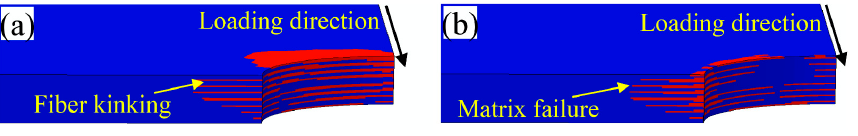
Figure 10. FEM results of circumferential section at B (( a ) fiber kinking failure, ( b ) matrix damage).